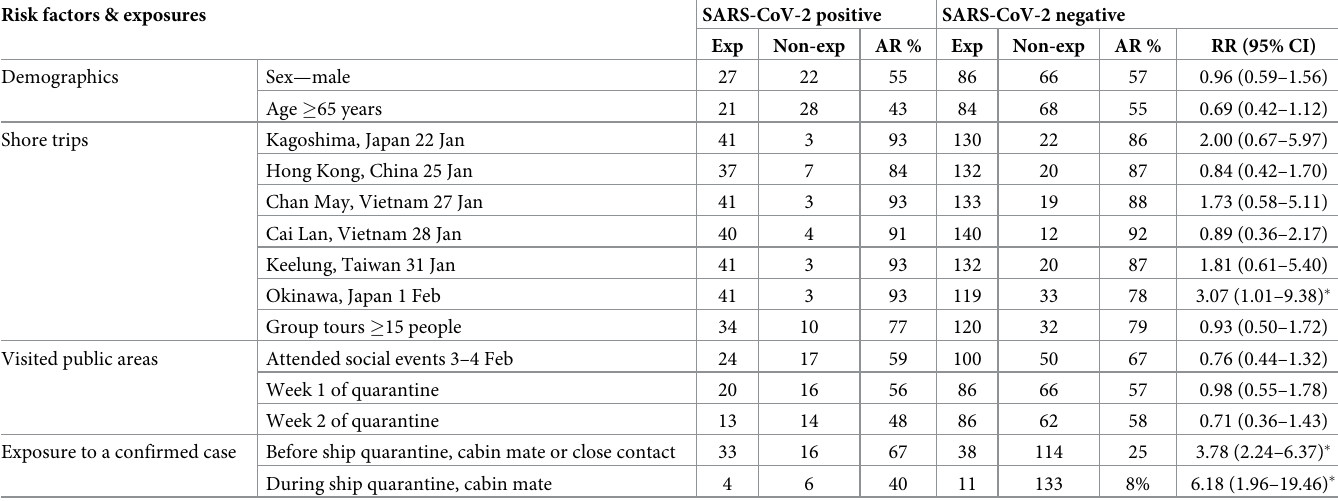
Table 3. Risk factors for SARS-CoV-2 infection among Australian passengers on the Diamond Princess cruise ship, March